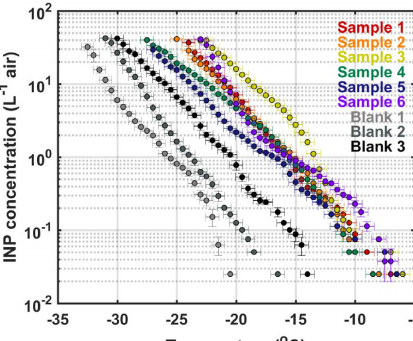
Figure 8. Cumulative INP spectra from the samples collected dur- ing the 25 May 2017 HOVERCAT test flight. Triplicate tests are binned every 0.5 ◦ C. The blanks indicate a triplicate test from UPW mixed alone in a beaker for 2h (Blank 1), UPW mixed in a WhirlPak ® bag for 2h (Blank 2), and an EmFab ® filter mixed in UPW in a WhirlPak ® bag for 2h (Blank 3). The latter is clos- est to how the samples were prepared. Error bars for the y and x axes correspond to standard deviation per 0.5 ◦ C bin and tempera- ture probe–plate versus drop variability standard deviation, respec- tively.